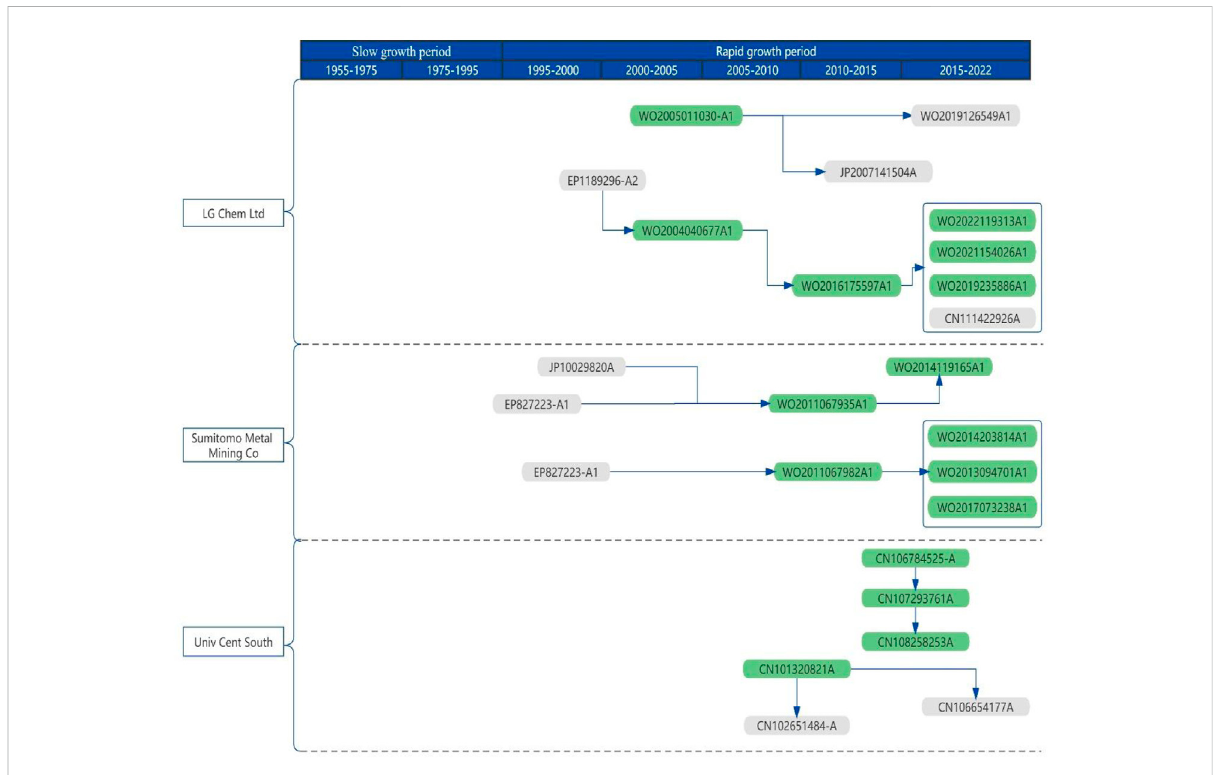
FIGURE 9 Collaborative network of patent applicants for key